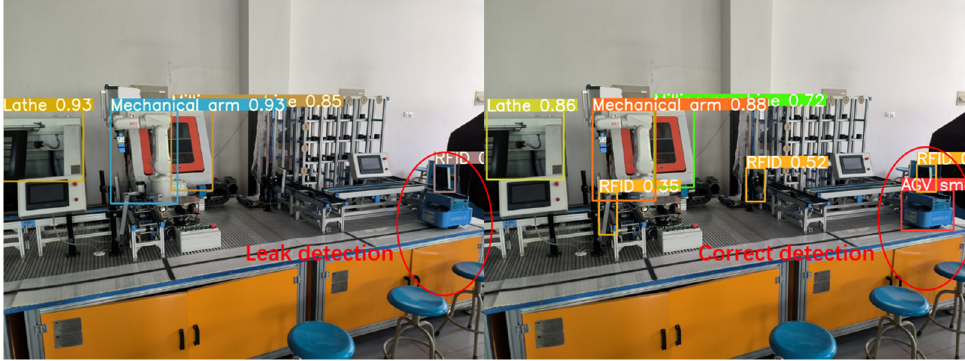
Figure 15. Comparison of recognition test results of YOLOv3 and the improved method.